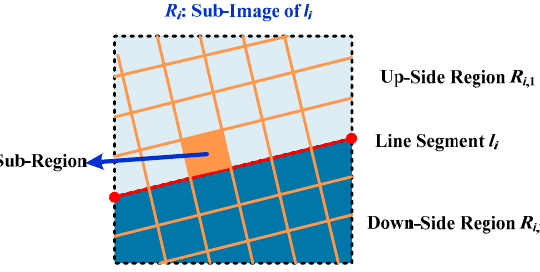
Figure 6. The up-side region R i, 1 and down-side region R i, 2 are divided into a series of